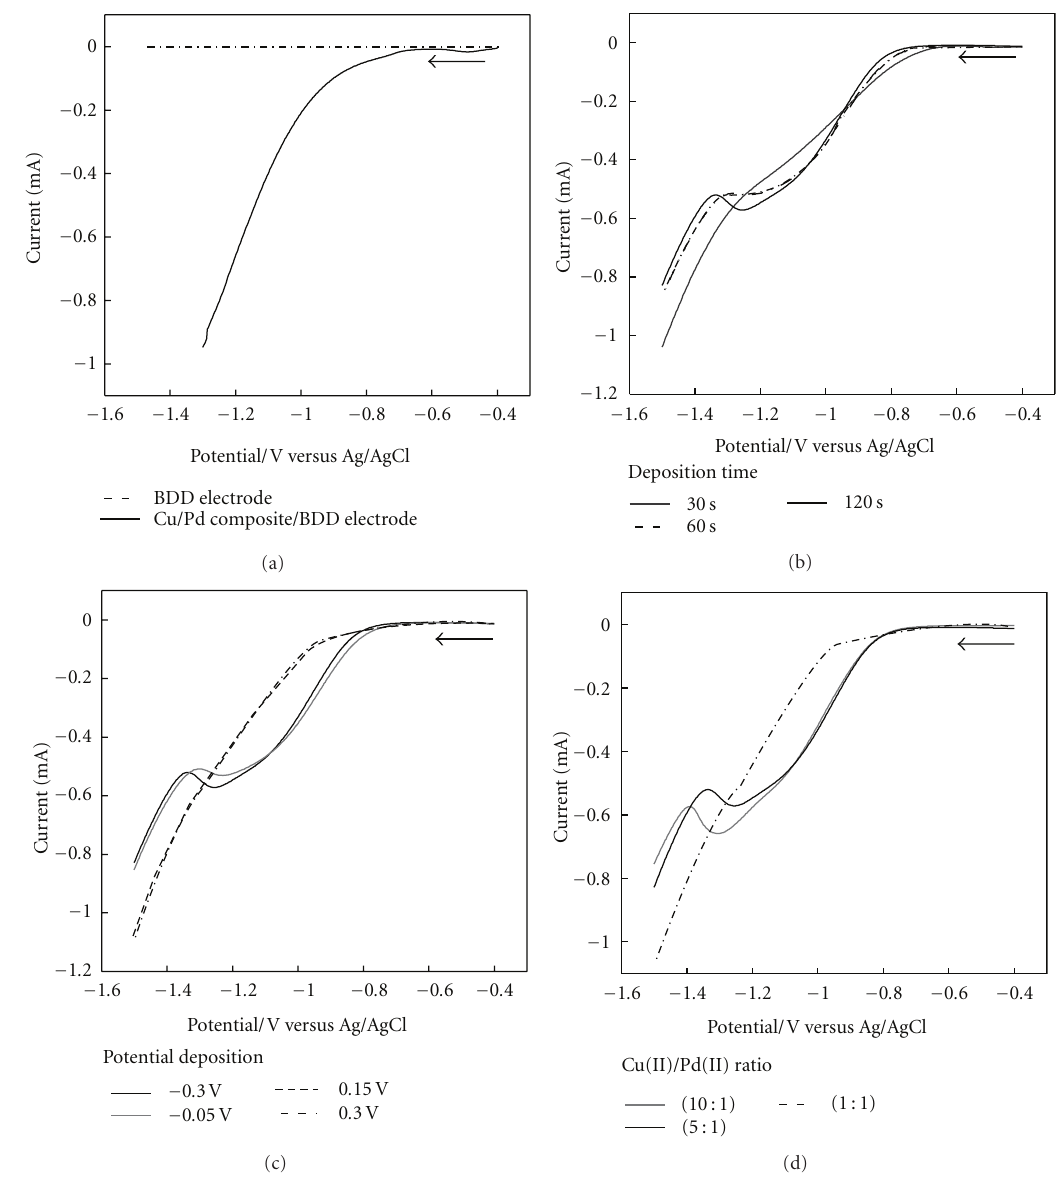
Figure 6: (a) LSV curves of the BDD and Cu/Pd-modified BDD electrodes in BR bu ff er solution (pH 9). Nitrate response of the Cu/Pd composite electrodeposited on BDD electrode at di ff erent (b) deposition time, (c) deposition potential, and (d) Cu(II): Pd(II) ratio. The nitrate response in (b) (c), and (d) was investigated in 0.1 M KNO 3 + BR bu ff er solution (pH 9). The Cu/Pd composite used in (a), (b), and (c) was electrodeposited using 5mM Cu(II) + 1mM Pd(II) + 0.5M HClO 4 . Scan rate of 10 mV s − 1